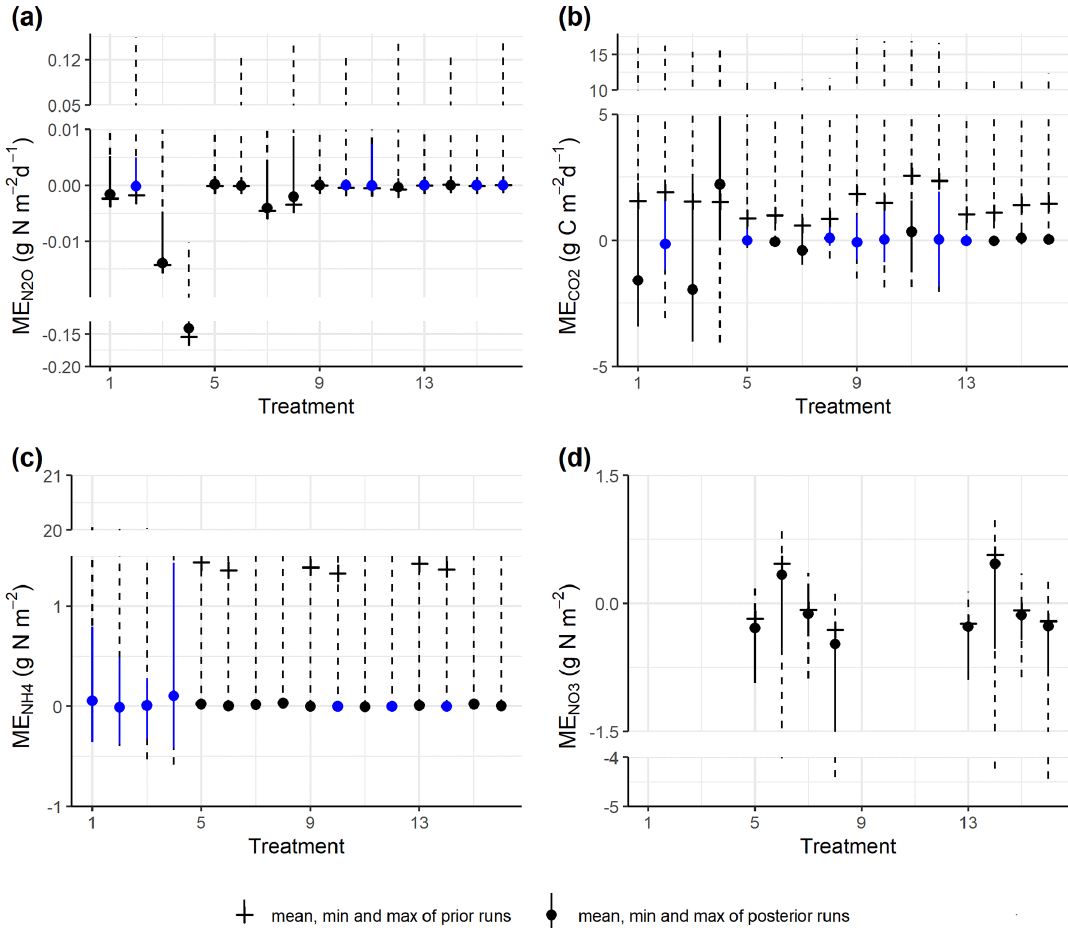
Figure 4. Comparison of the ME ranges between prior simulations and posterior (accepted) simulations for (a) daily N 2 O fluxes, (b) CO 2 fluxes, (c) soil NH + content, and (d) soil NO − content. The blue color shows ME values not significantly different from zero by one-sample 4 3 t tests (significance level α = 0.05). Treatment indices 1–4 represent treatments for mix RC, 5–8 for control RC, 9–12 for mix WW,